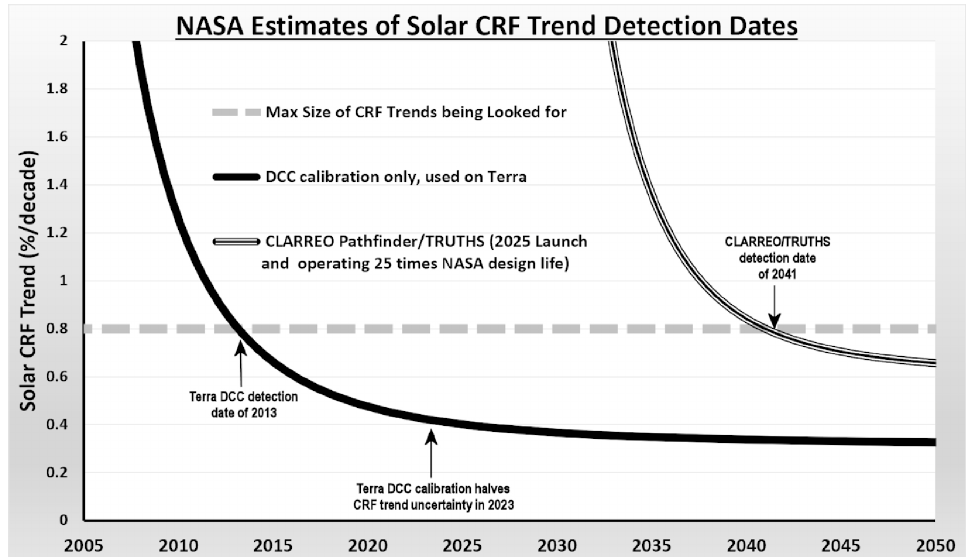
Figure 6. NASA calculated Solar cloud climate signal sizes and dates of their possible detection instruments combined with CLARREO Pathfinder/TRUTHS (grey) [3,35,36]. The same using DCC albedo is shown in black, in which case the narrowing of CRF uncertainty in GCM simulations could begin before 2015, using existing Terra results at no